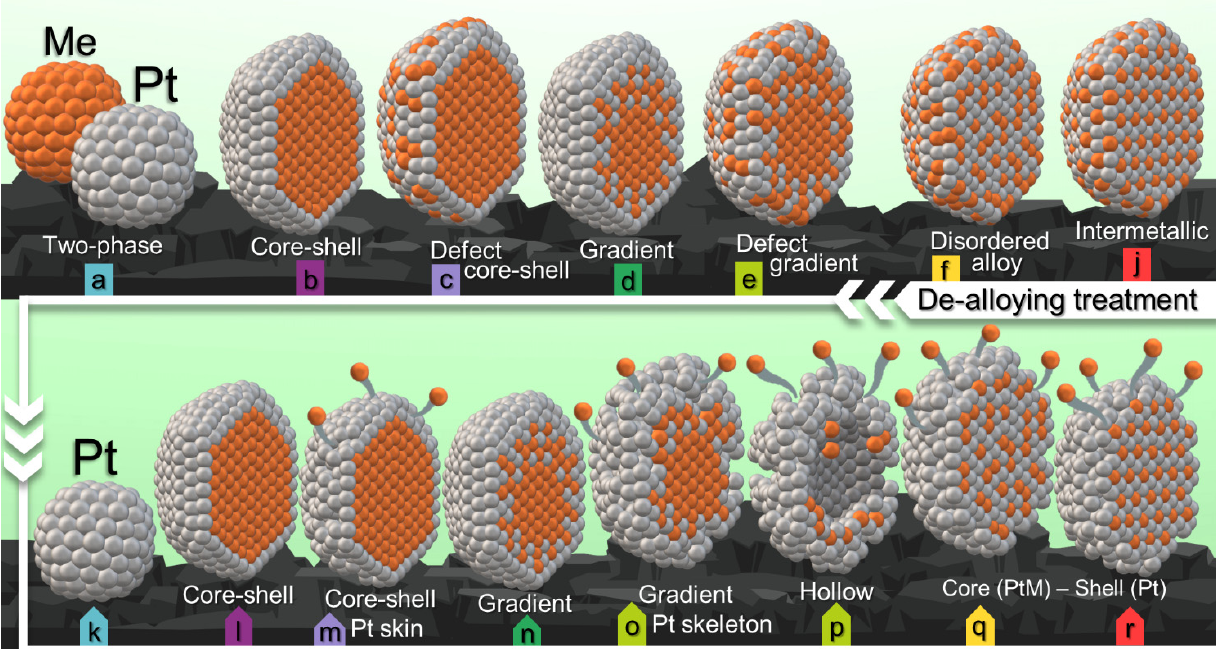
Figure 2. Scheme of possible transitions of bimetallic NPs structures under the influence of de-alloyed pre-treatment: ( a ) two-phase, ( b , l ) core-shell, ( c ) defect core-shell, ( d , n ) gradient, ( e ) defect gradient, ( f ) disorder alloy, ( j ) intermetallic, ( k ) Pt phase, ( m ) core-shell Pt skin, ( o ) gradient Pt skeleton, ( p ) hollow, ( q , r ) core(PtM)-shell(Pt) with order PtM alloy ( r ) or disorder PtM alloy ( q ). Platinum atoms are marked in gray; atoms of the alloying component are marked in orange. The top row represents examples of bimetallic nanoparticles structures in the “as-prepared” state. The bottom row represents the bimetallic particles structures after de-alloying treatment. The process of atoms of the alloying component dissolution is shown. The background color of the letters corresponds to the same structure before and after